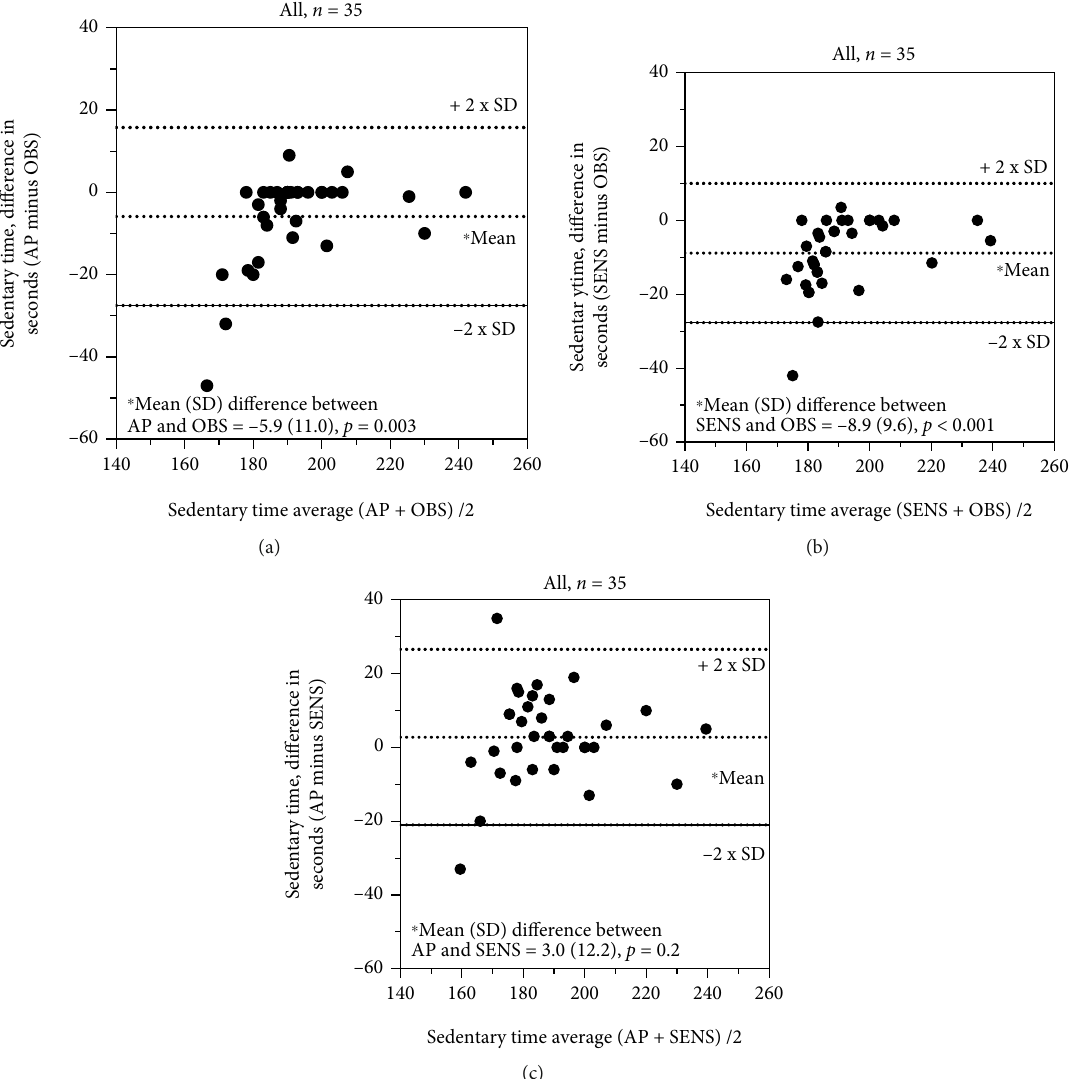
Figure 5: (a – c) Recording of sedentary time: comparison between ActivPAL3 ™ , SENS motion®, and direct